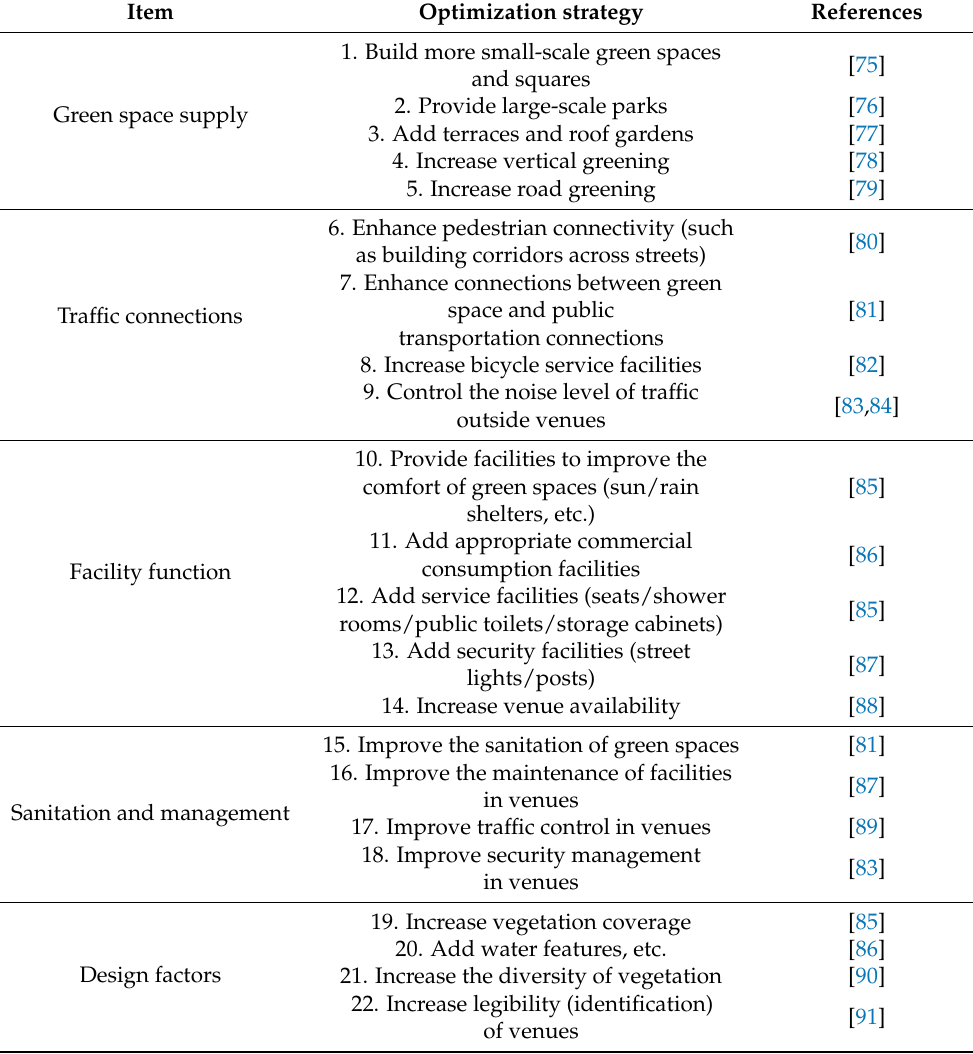
Table 4. Specific strategies of subjective